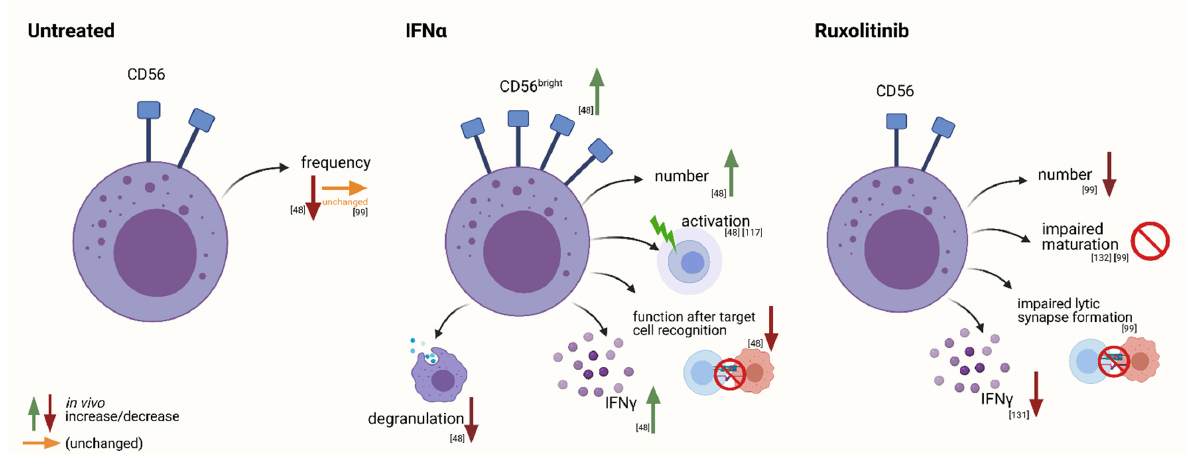
Figure 3. In vivo alterations to the NK cell compartment of Ph − MPNs before therapy initiation, as well as with IFN α or ruxolitinib therapy. Green arrows represent an increase in the frequency of specific properties observed, while red indicate a decrease or impairment, and yellow indicates no change. References are displayed in brackets. Created with BioRender.com (accessed on August 27 th 2021).